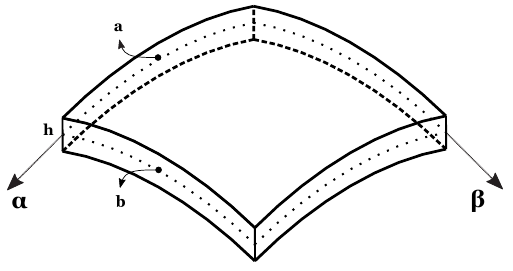
Figure 7. The spherical shell geometry for Case 4.